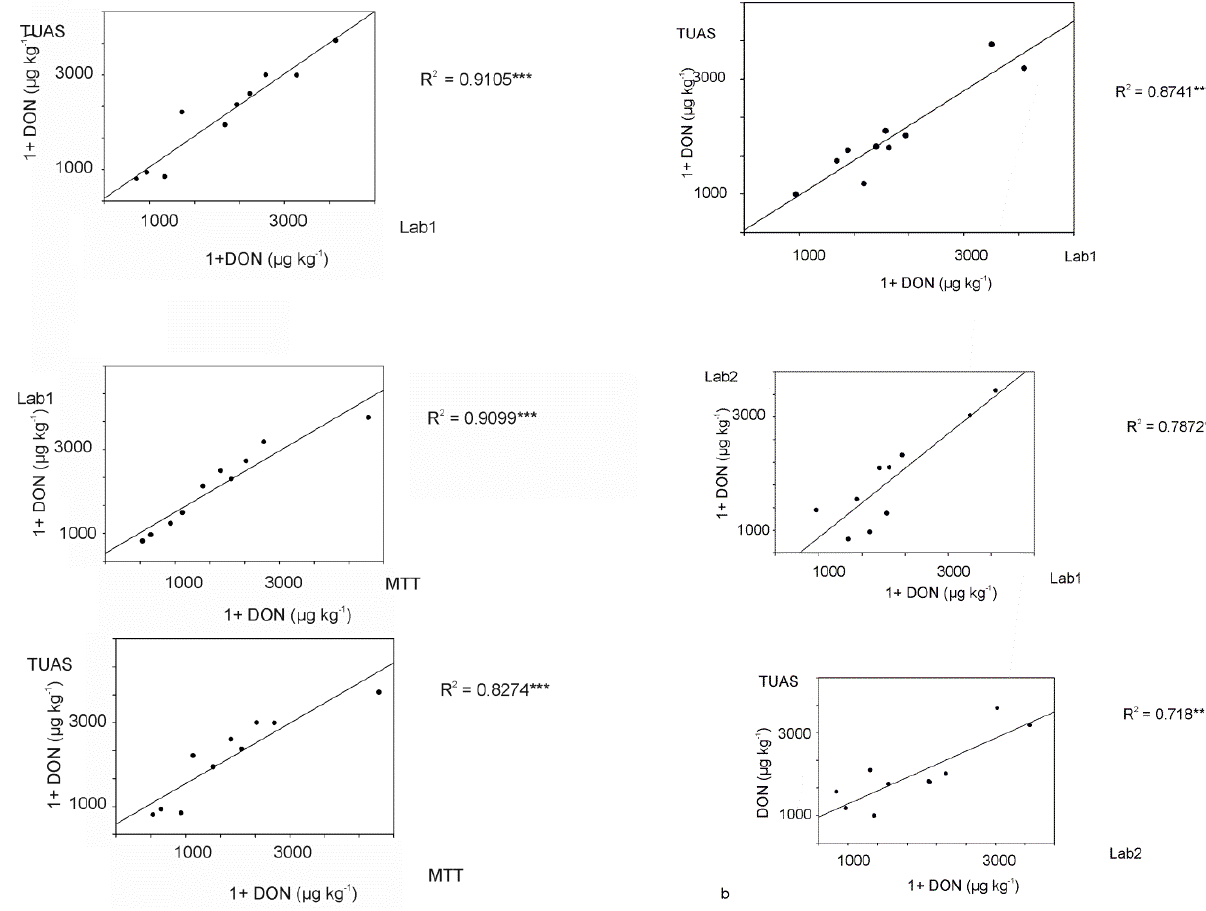
Figure 4. Correlations between log DON concentrations in oat grain processed at two milling company laboratories (Lab 1 and Lab 2), compared with DON concentrations measured at TUAS and MTT. The grain samples were ground at MTT (a) in a mill with a sieve, or at Lab 1 (b) in a mill without a sieve. *** and ** indicate statistically significant ( P <0.001 or